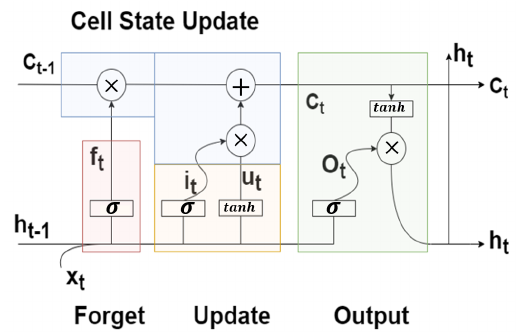
Figure 2. Long Short-Term Memory (LSTM)